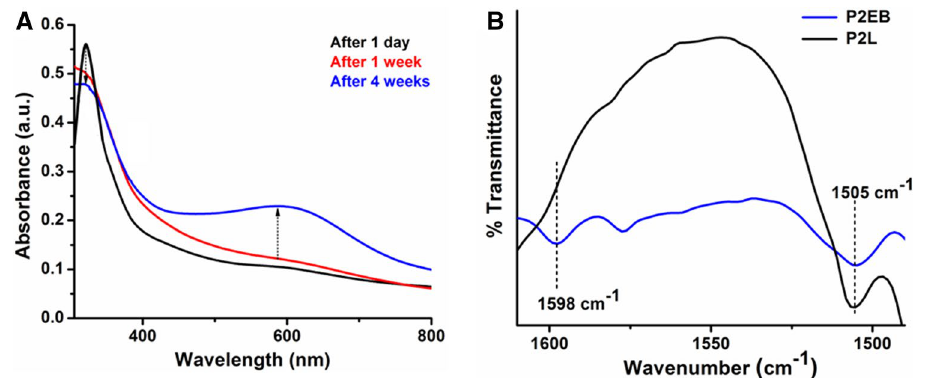
Figure 5. Air oxidation of P2L. UV–Vis−NIR spectra ( A ), and FTIR spectra ( B